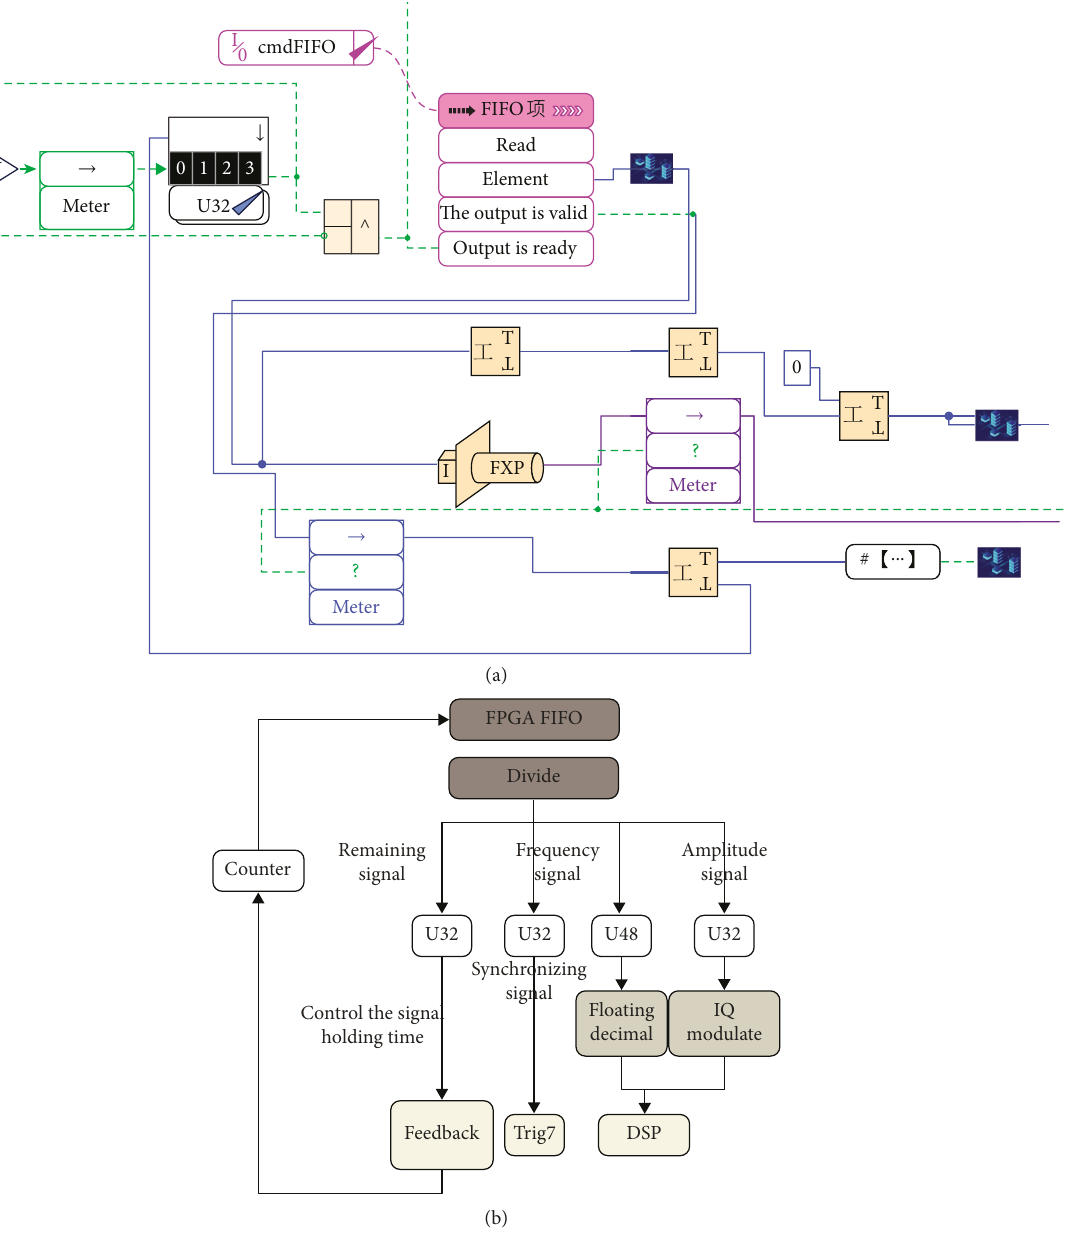
Figure 5: FPGA data module. (a) FPGA reads data. (b) FPGA signal flow of the